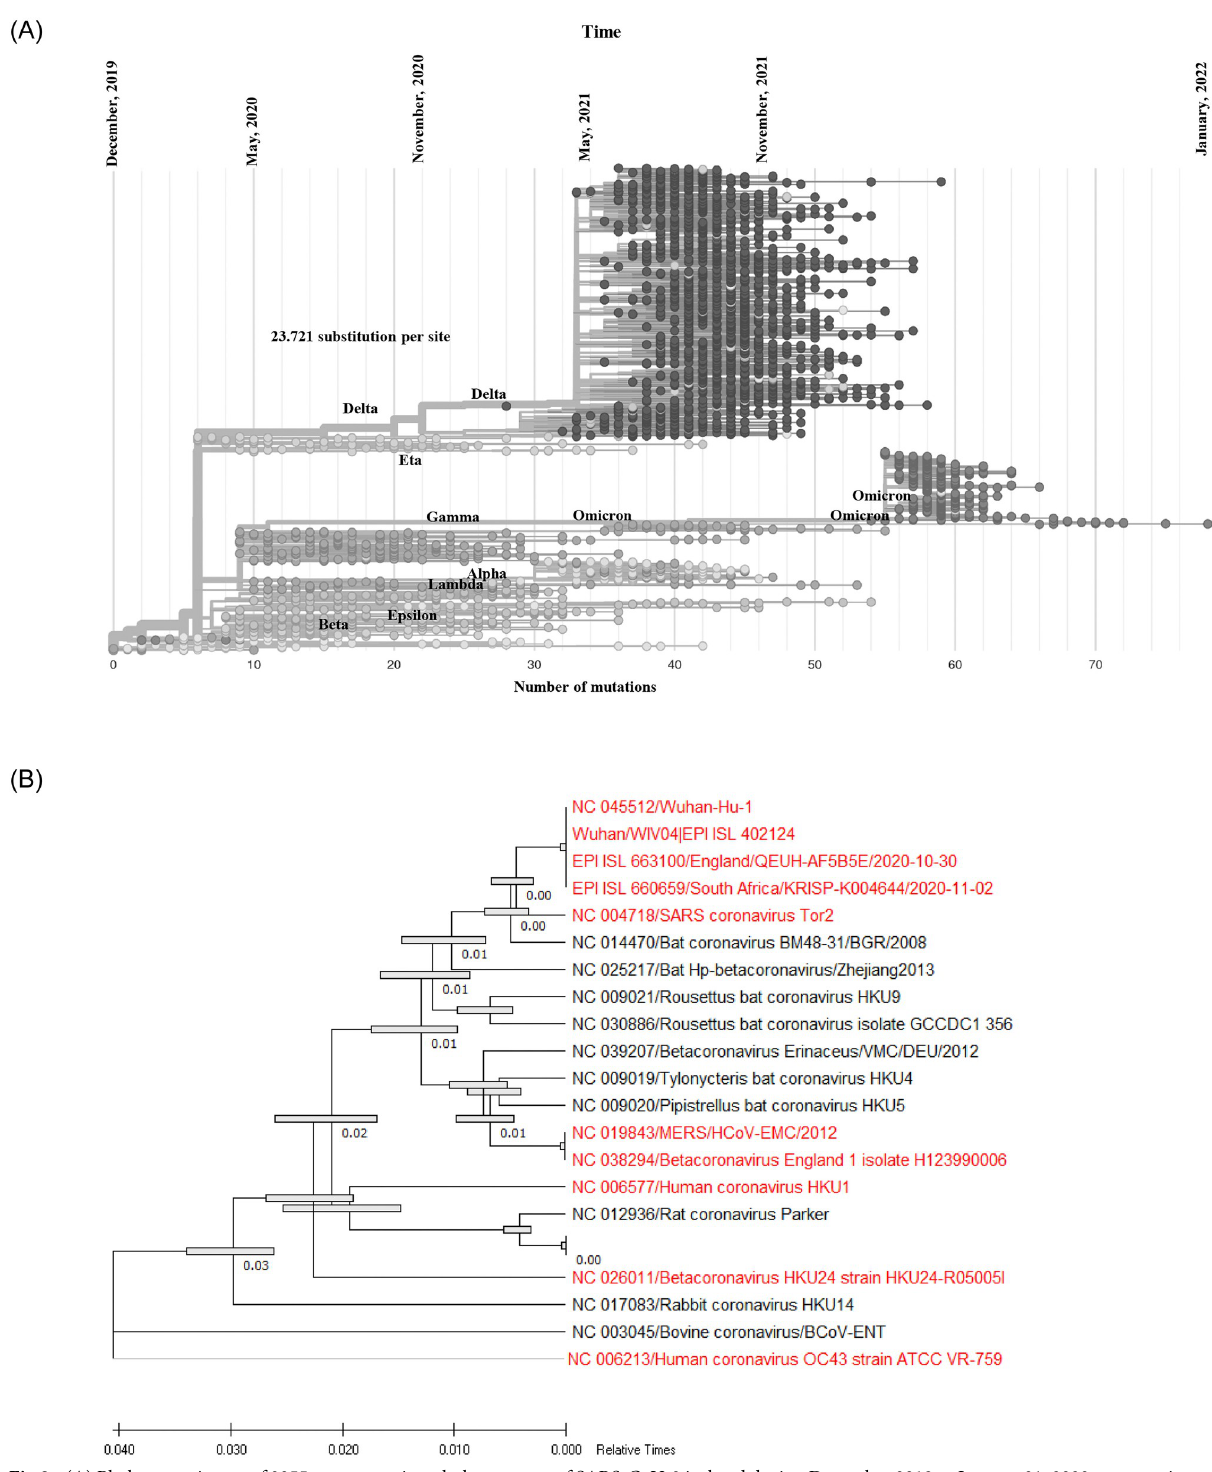
Fig 8. (A) Phylogenomic tree of 3055 representative whole genomes of SARS-CoV-2 isolated during December 2019 to January 31, 2022 representing the diversity and evolution of different variants. The tree is rooted relative to early samples from Wuhan, China. Nucleotide substitution rate of 8 × 10 − 4 subs per site per year was represented by single temporal resolution. Mutational frequency was calculated by using previous model (Obermeyer et al). The lower scale represented number of mutations and the upper scale indicated timeline of evolution. Wuhan-Hu-1/2019 was used as reference sequence in this analysis. (B) Phylogenetic tree of the whole genome of available reference sequences of coronaviruses isolated from different animals